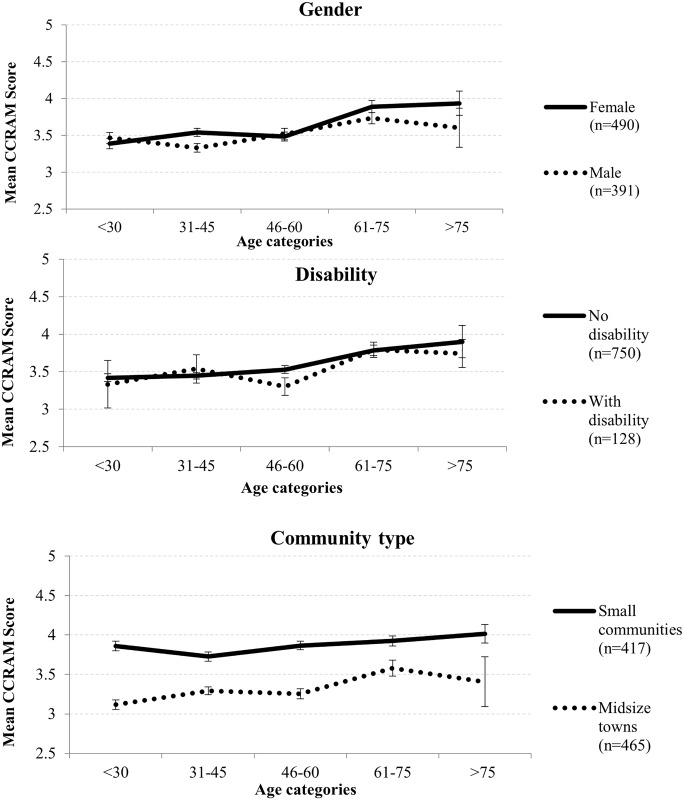
CCRAM factors according to age categories.